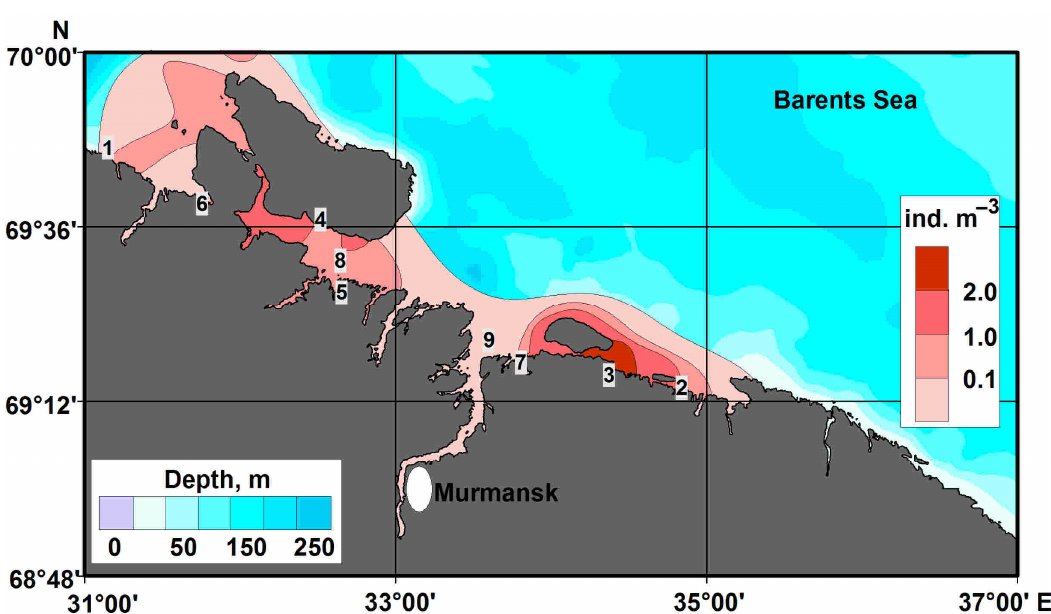
Figure 3. Distribution and abundance (individuals m –3 ) of red king crab larvae (zoea I) in Russian waters of the Barents Sea (spring 1996–1997) (modified from [68]). 1—Varanger-fjord, 2—Maly Oleniy Island, 3—Medvezhya Bay, 4—Eina Bay, 5—Vichany Bay, 6—Bolshaya Volokovaya Bay, 7—Dolgaya Bay, 8—Motovsky Bay, 9—Kola Bay.